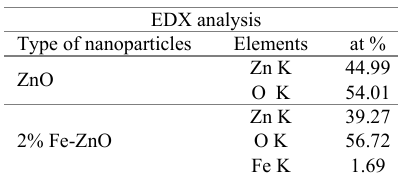
Table 2 EDX analysis of nanomaterials Table 2. EDX analysis of